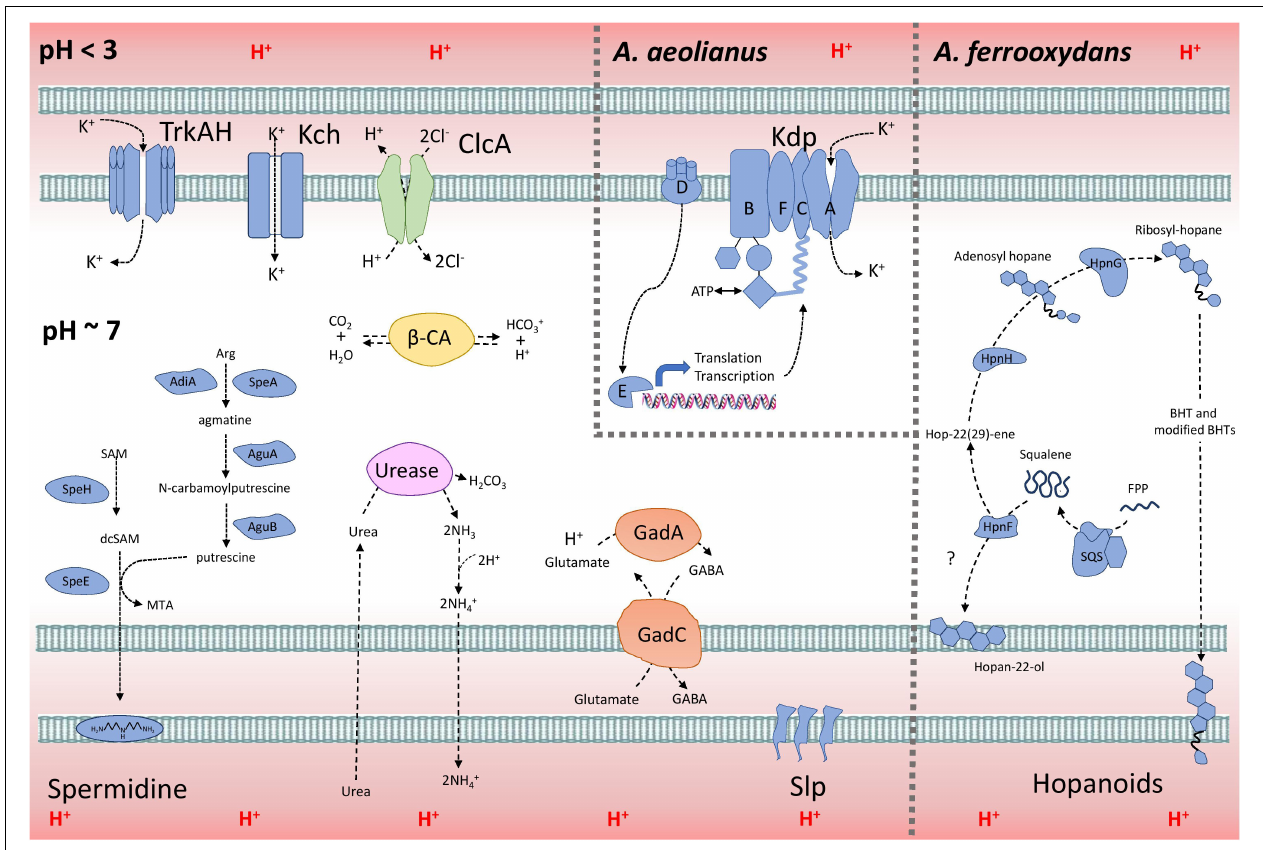
FIGURE 7 | The model of acid resistance in the Acidihalobacter spp. First line of defense mechanisms are displayed in blue and second line of defense mechanisms are displayed in other colors (green = Clc A; yellow = β -CA; purple = urease system; and orange = Gad